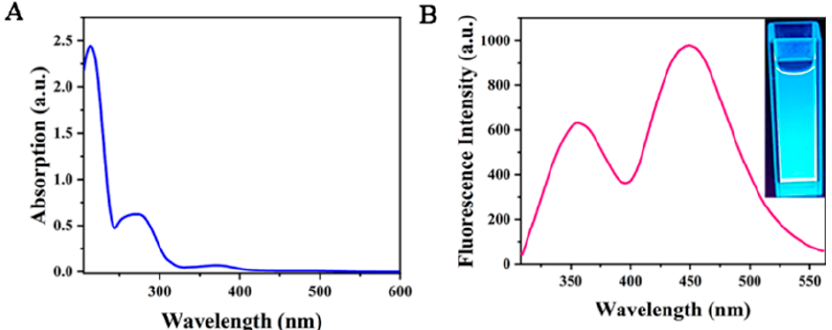
Figure 5. FTIR spectra of Cu-CDs.